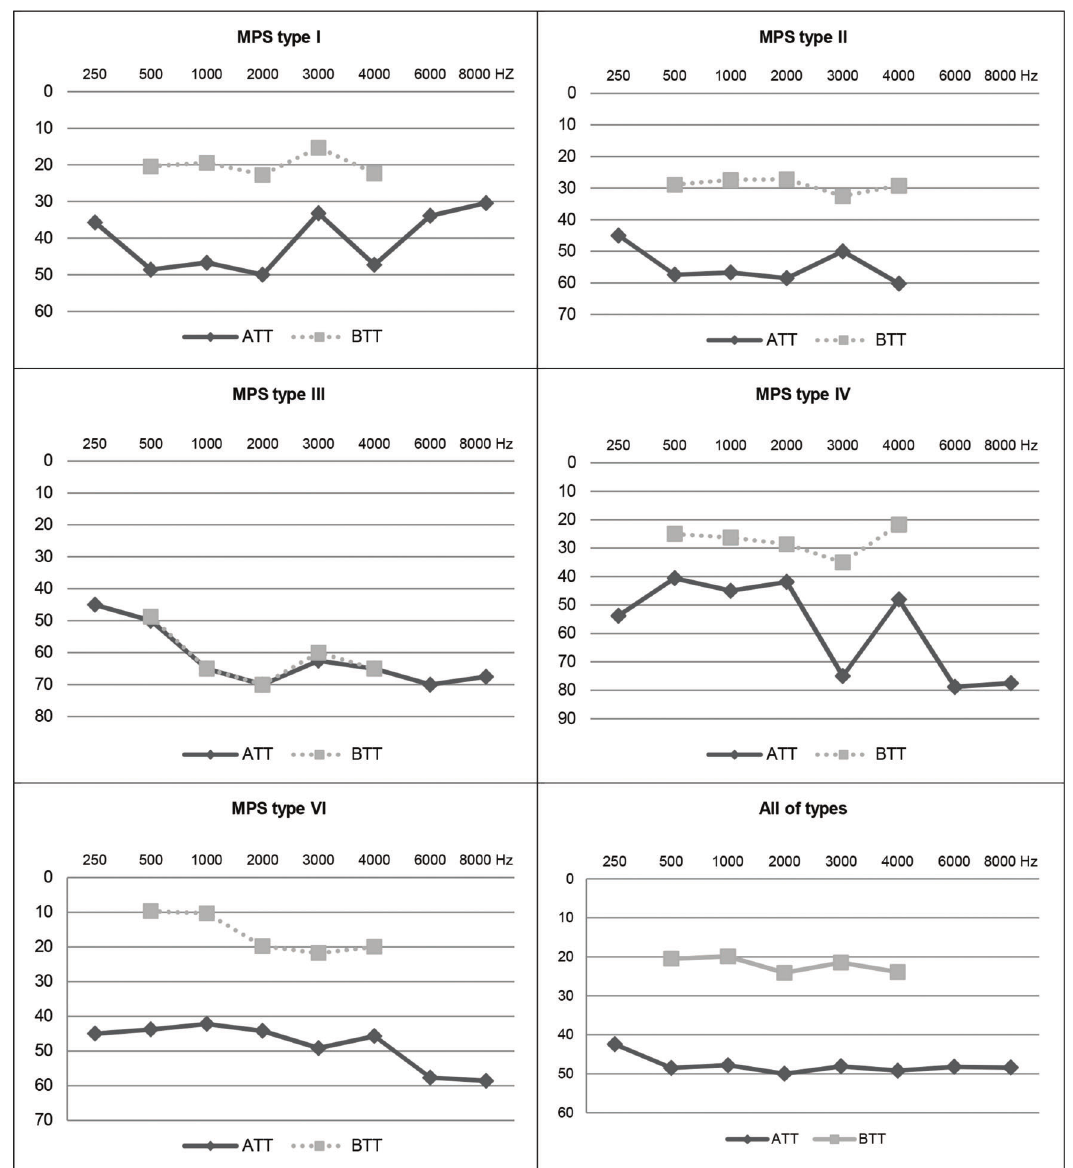
Figure 1 - Representation of the audiograms of mean transmission thresholds by frequency (total sample) for each type of MPS. Legend: Air transmission threshold (ATT); Bone transmission threshold (BTT); mucopolysaccharidosis